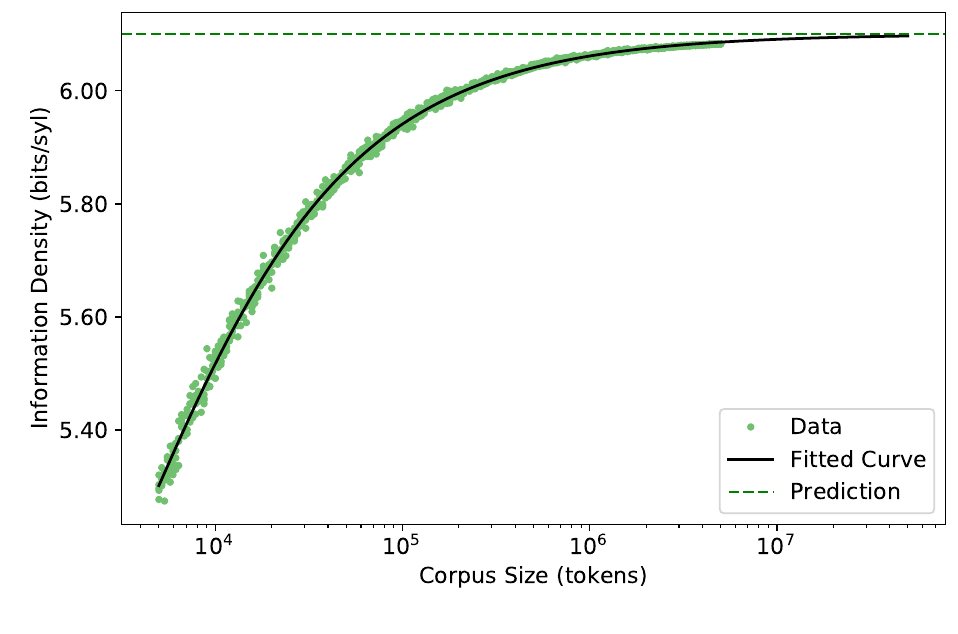
Figure 1. The convergence of estimated information density for German, approximated by equa- tion 8.